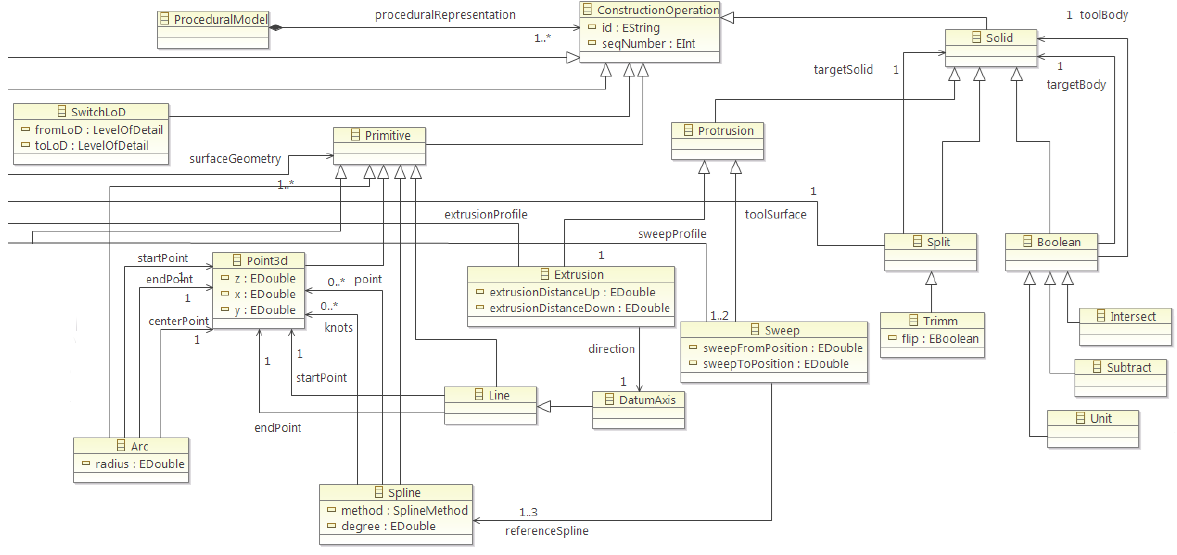
Figure 10. Section of the developed data model for capturing a procedural model (UML class